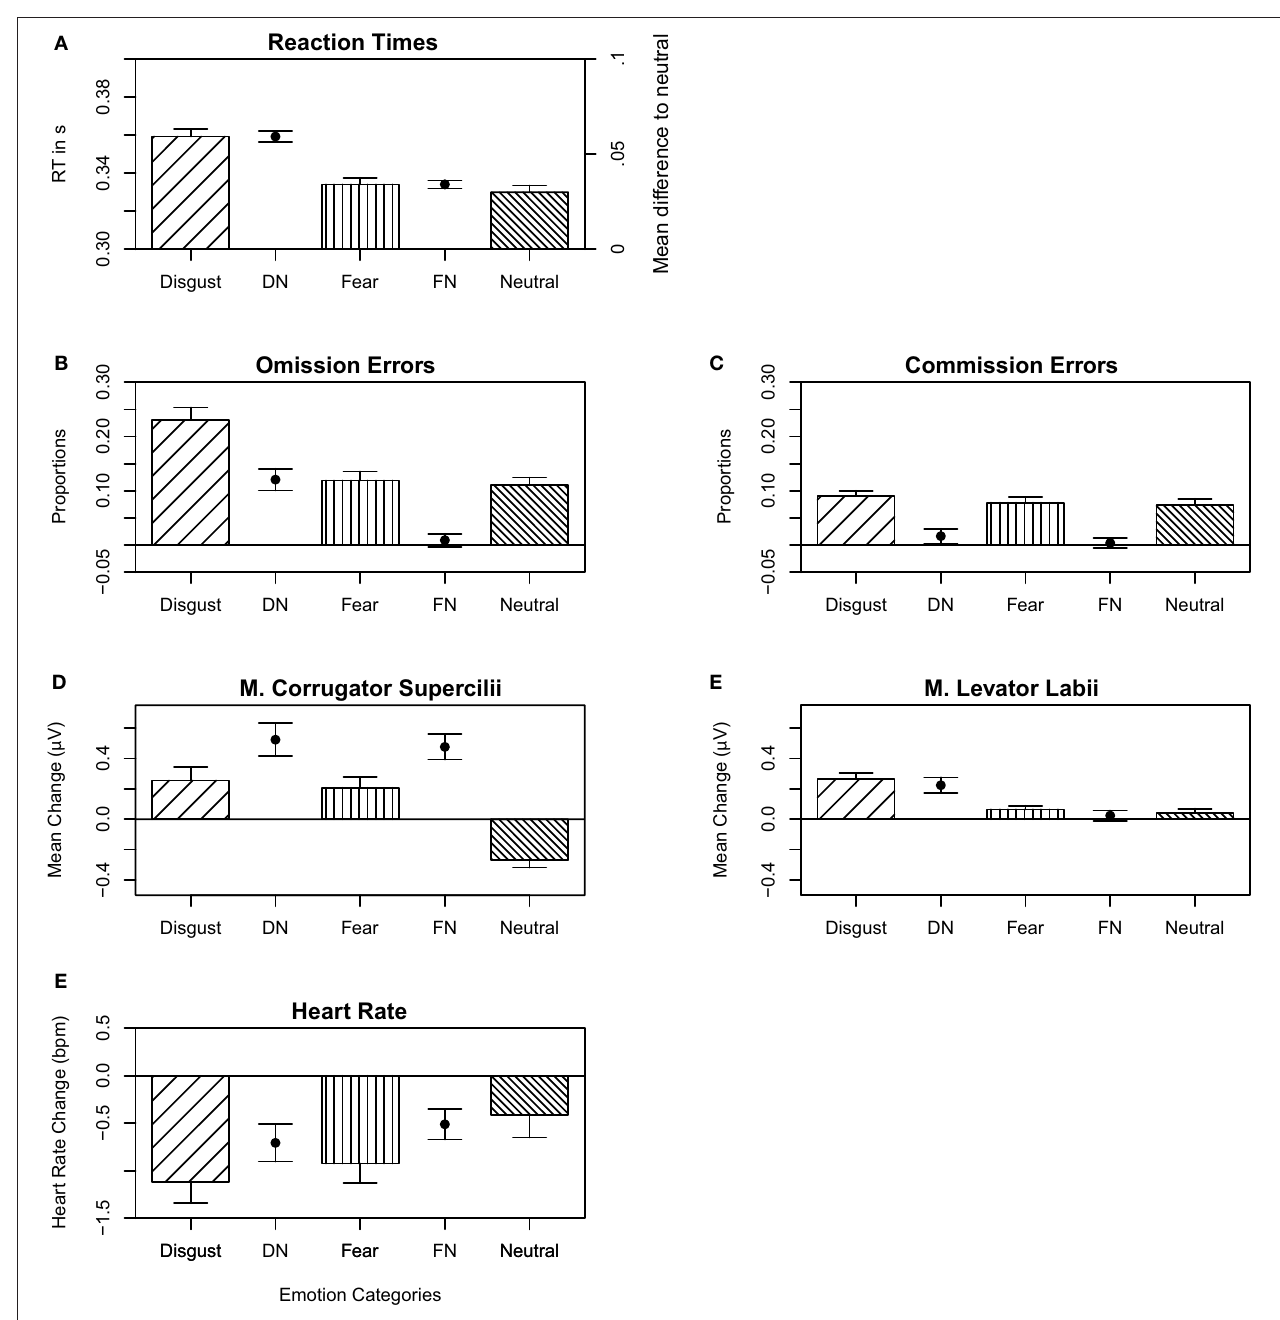
FIGURE 1 | In the upper-left (A) , the reaction times are presented; in the second row on the left (B) and in the right (C) , proportions of the errors of omission and proportions of the errors of commissions are shown, respectively. In the third row in the left (D) , the m. corrugator supercilii mean change activity is presented, and in the lower-right (E) , the m. levator labii mean change activity is presented. In the lower-left (F) , the mean heart rate change is shown. (A–F) show data means and standard errors of the disgust, fear, and neutral emotional category. In between the three emotion categories, the mean differences between disgust and neutral as well as between fear and neutral category are presented. When the means differ from the y-axis, the means are shown on the right side of the (A) . Response